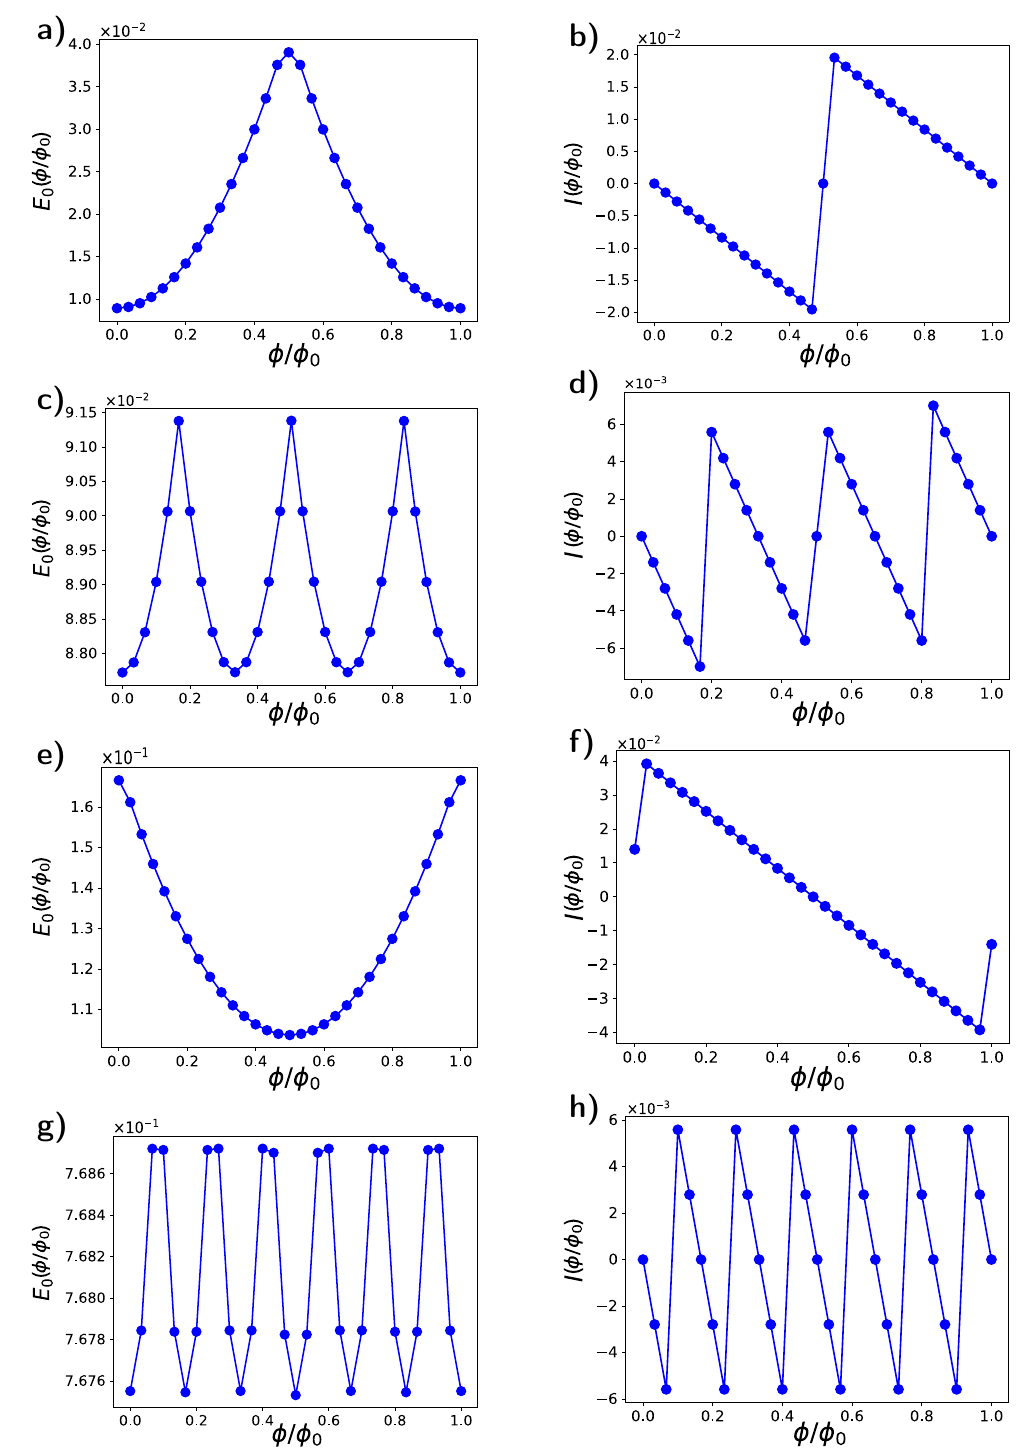
Figure 11: SU( N ) persistent current and the corresponding ground state energy at incommensurate filling for different interaction strengths U . a),b) Ground state en- = 3 for U = 0.1. c),d) Ground state energy and ergy and Persistent current for N p = 3 for U = 10,000. e),f) Ground state energy and Per- persistent current for N p = 6 for U = 0.1. g),h) Ground state energy and persistent sistent current for N p = 6 for U = 10,000. All curves are calculated with Bethe ansatz for current for N p the Gaudin-Yang-Sutherland model with L =